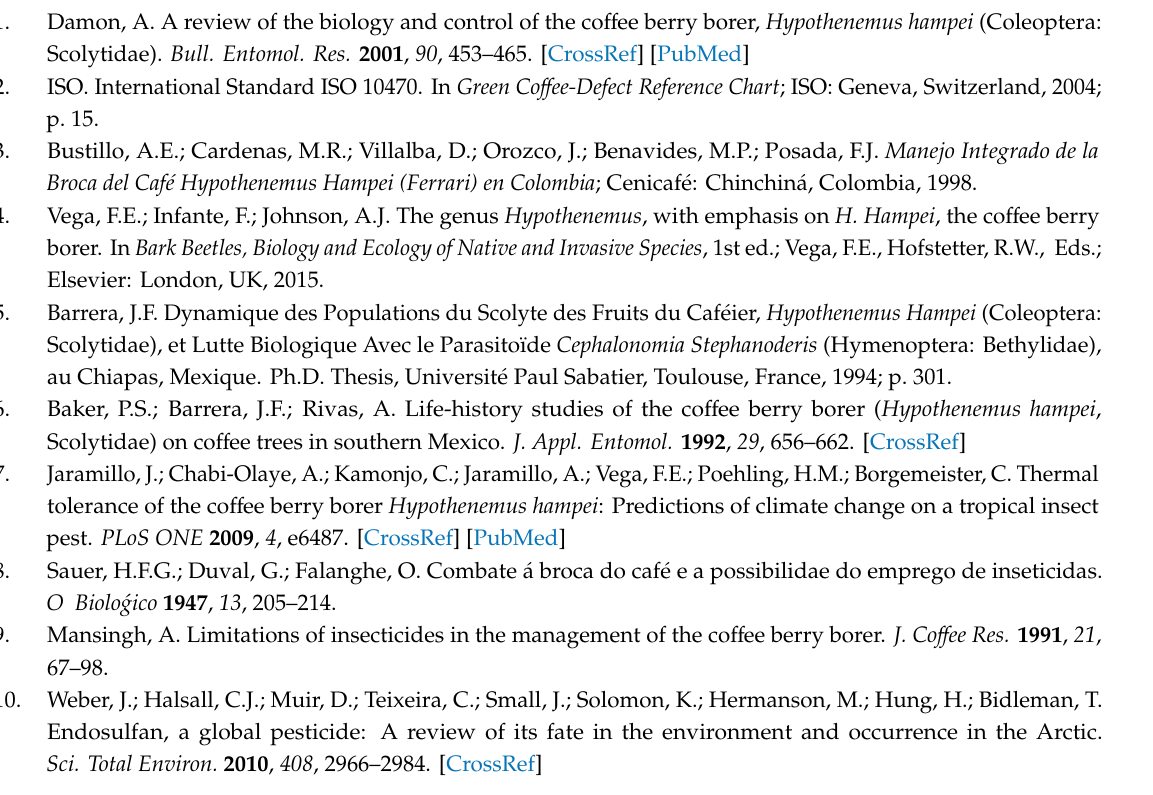
Figure S1: Ripe fruit infestation over time in two Hawai’i Island co ff ee farms, Figure S2: Position of CBB (AB or CD) within co ff ee fruits on two Hawai’i Island co ff ee